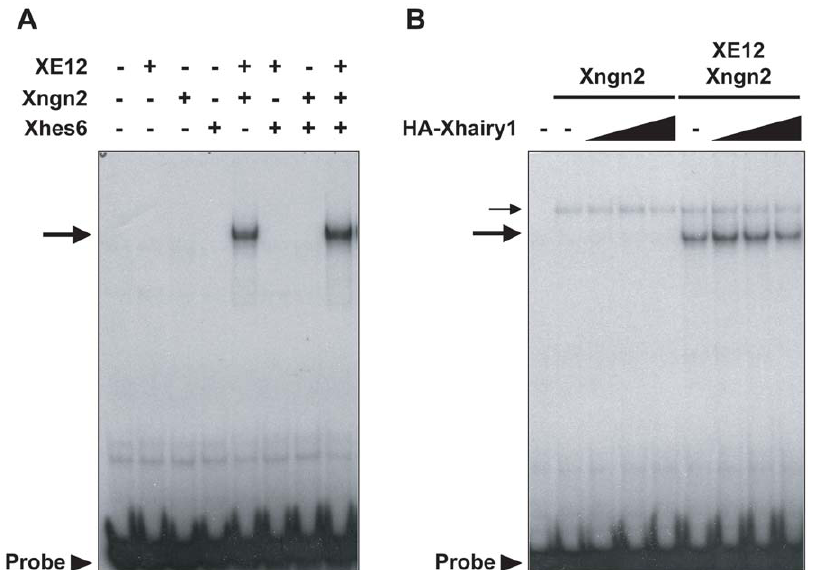
Figure 4. Effects of Hes6 and Xhairy1 proteins on Xngn2/E12 DNA-binding activity. A DNA fragment containing E-box element from the mouse NeuroD promoter was labeled with 32 P and incubated with the in vitro translated proteins shown. The reaction mixture was then analyzed on a native polyacrylamide gel. (A) Effect of Xhes6 on DNA-binding activity of Xngn2/E12. Arrow indicates complex of Xngn2/E12 and DNA. Free probes are shown by arrowhead. (B) Effect of Xhairy1 on DNA-binding activity of Xngn2/E12. Faint bands with slow mobility (thin arrow) are non-specific protein and DNA complexes. Thick arrow indicates Xngn2/XE12 probe complex. Neither Xhes6 and Xhairy1 affect heterodimer formation or the DNA binding activity of Xngn2/XE12